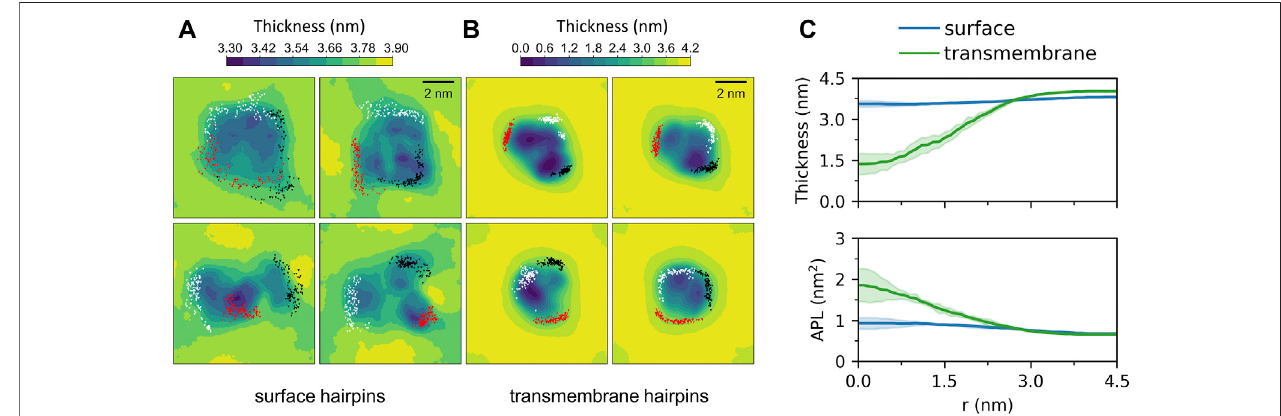
FIGURE 4 | Two-dimensional maps of membrane thickness for (A) surface and (B) transmembrane HAfp con fi gurations. Dots correspond to positions visited by N-terminal amino group of each HAfp recorded every 10 ns. (C) Average membrane thickness and area per lipid (APL) as functions of distance from HAfps centre of mass. Shadows correspond to one standard deviation across 4 MD runs.